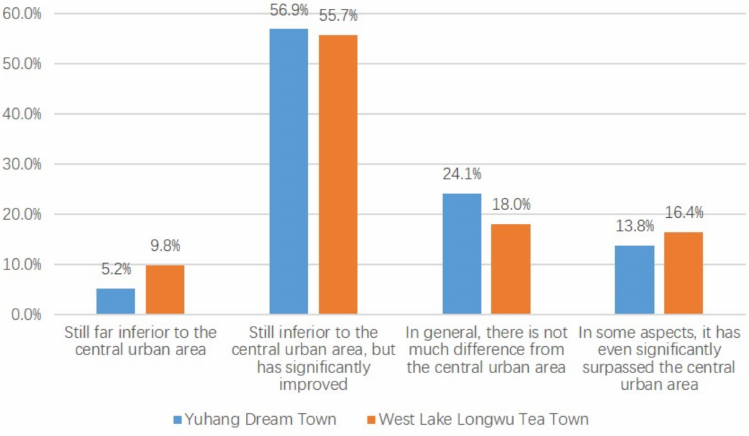
Figure 17. Respondents’ evaluation of family living standards under the CT practice compared with the living standards of central urban areas (source: